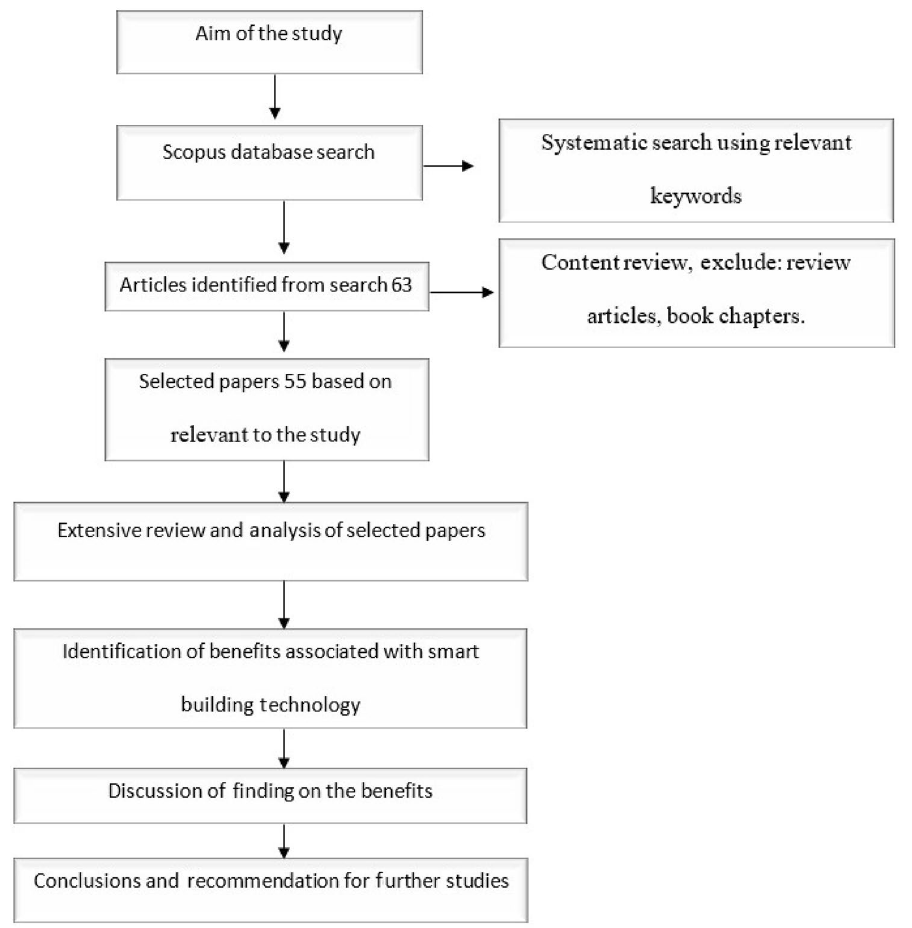
Fig. 1 Overview of the research